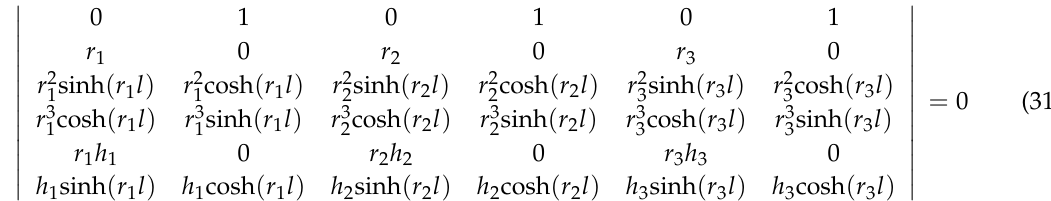
Table 1. Mechanical, thermal, physical and electrical properties of gyroscope with silicon material. Mechanical E / GPa